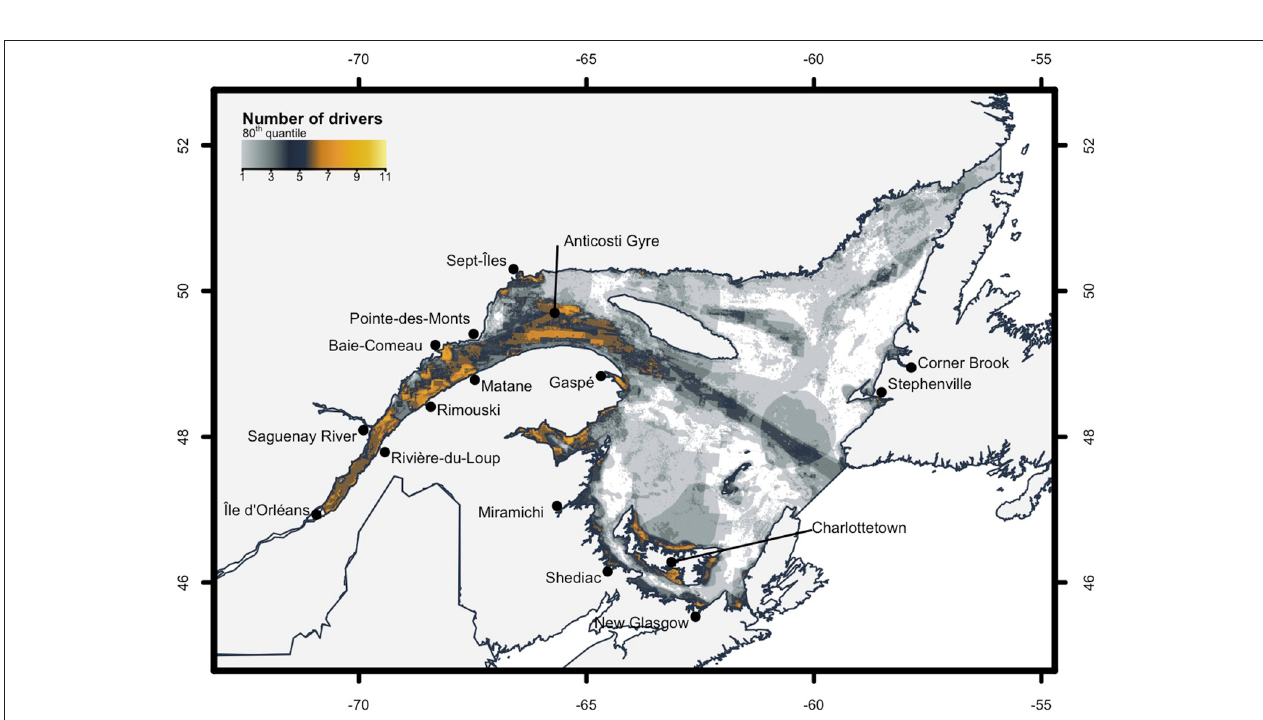
FIGURE 4 | Distribution of cumulative hotspots in the St. Lawrence System.